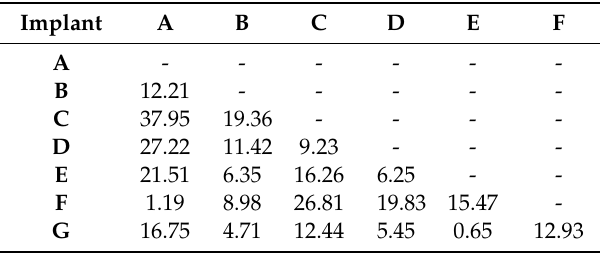
Table 5. The calculated values of statistic t